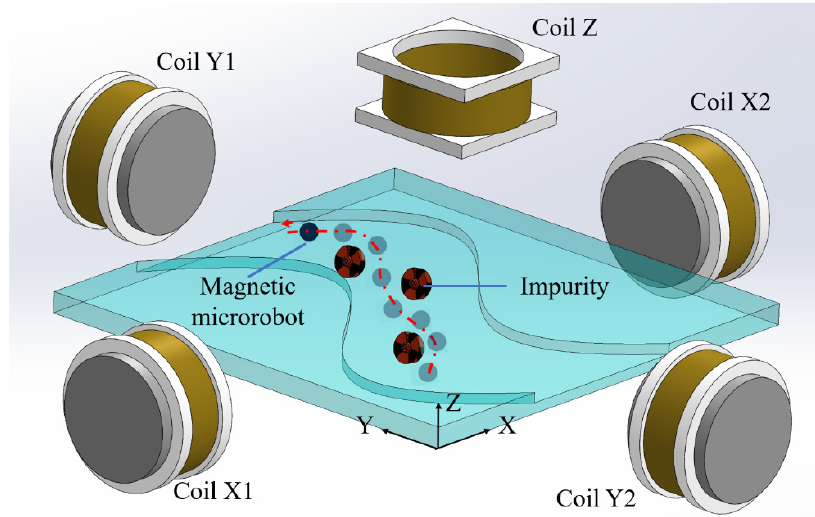
Figure 1. Diagram of a magnetic microrobot moving in the microchannel along the automatic recognition path.